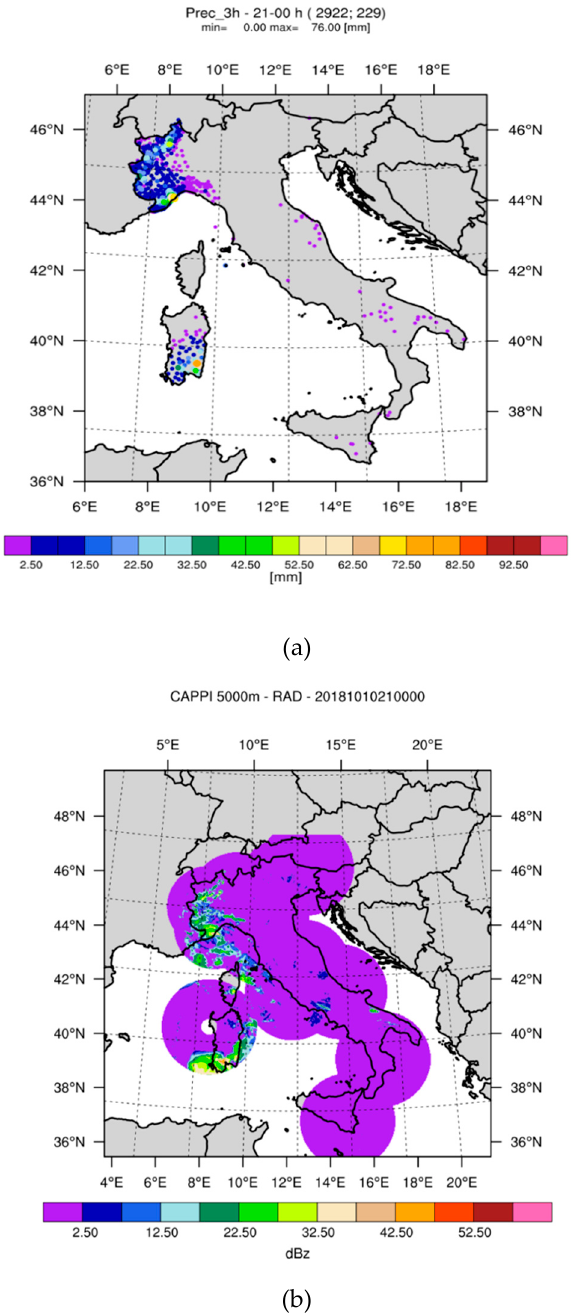
Figure 4. ( a ) rainfall observed by the Italian rain gauge network between 21 UTC on 10 October and 00 UTC on 11 October; ( b ) CAPPI at 21 UTC on 10 October and at 5 km height. Radar composite is obtained from the 22 radars of the Italian network.